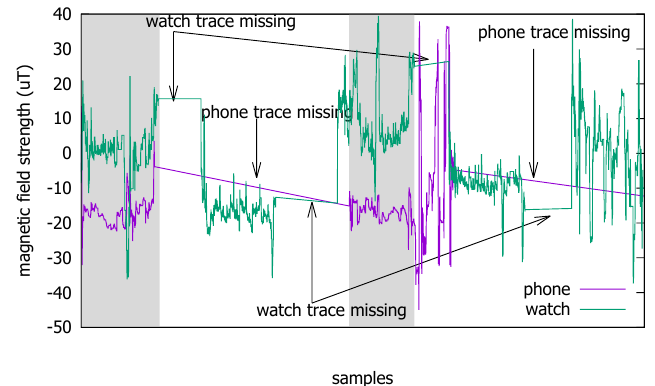
Figure 5. Magnetometer traces from the two mobile devices partially overlap over certain time periods in the Pisa